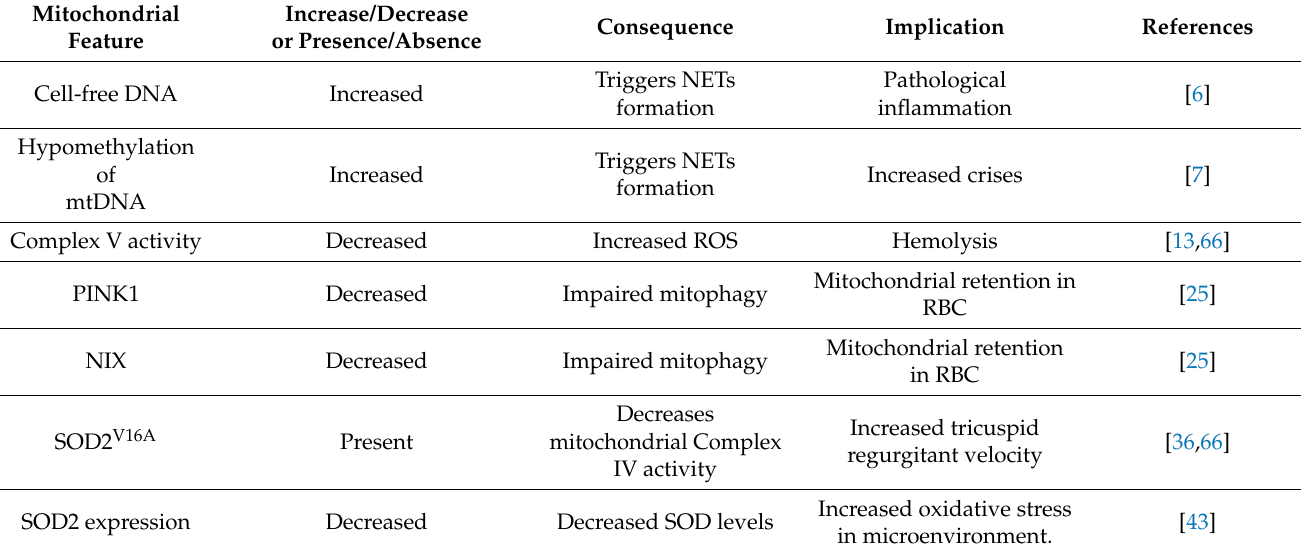
Table 2. Mitochondrial markers in